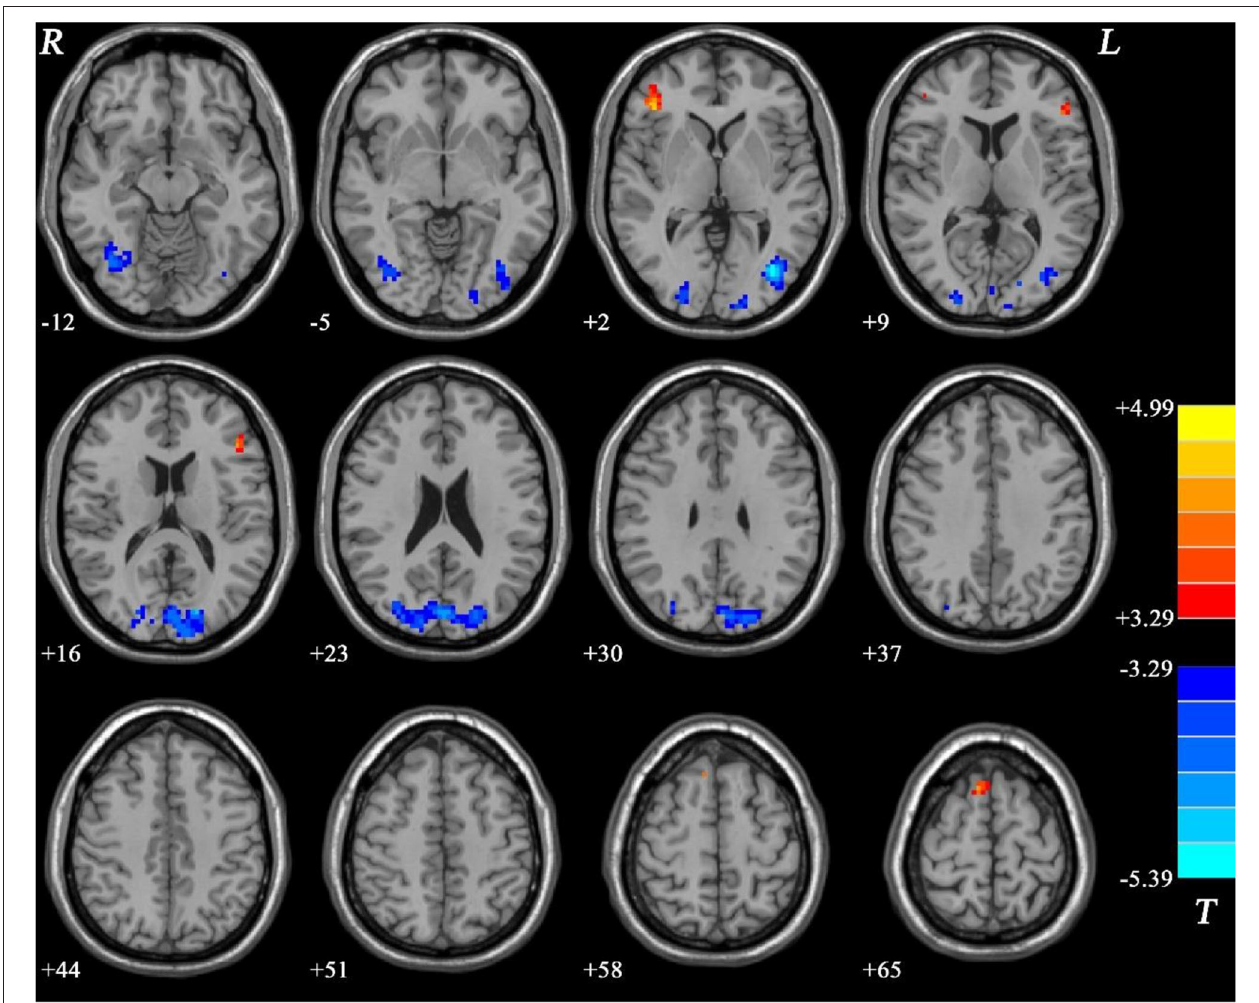
FIGURE 2 | Fractional amplitude of low-frequency fluctuation (fALFF) differences between melancholic major depressive disorder (MDD) and healthy controls (HCs). Red and blue represent increased and decreased regional spontaneous activity in the patients,